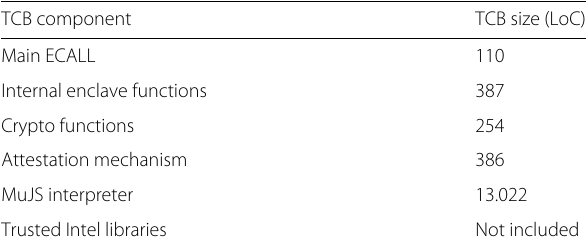
Table 3 TCB Components and their size in line of C code. Based on software TCB size of